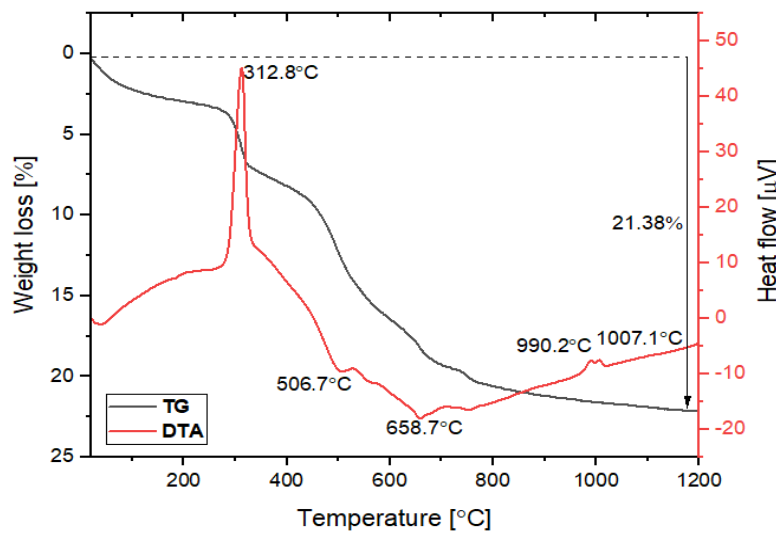
Figure 3. TG-DTA curves for mixed powder.